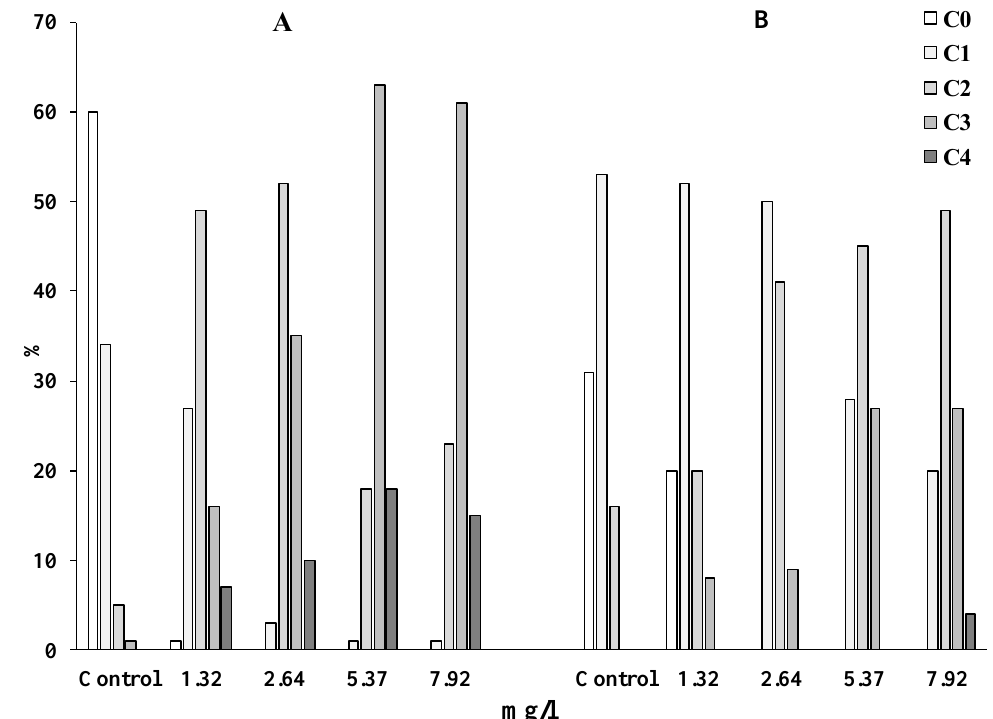
Figure 2. Distribution of comets according to the classes in sperm ( A ) and eggs ( B ) of the sand dollar S. mirabilis after exposure to different concentrations of WAF-DF.